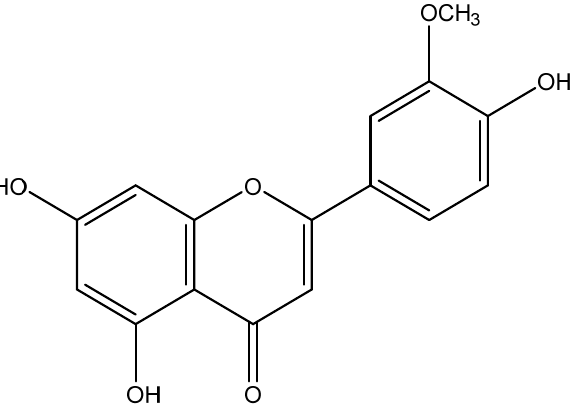
Figure 1. Chemical structure of chrysoeriol.